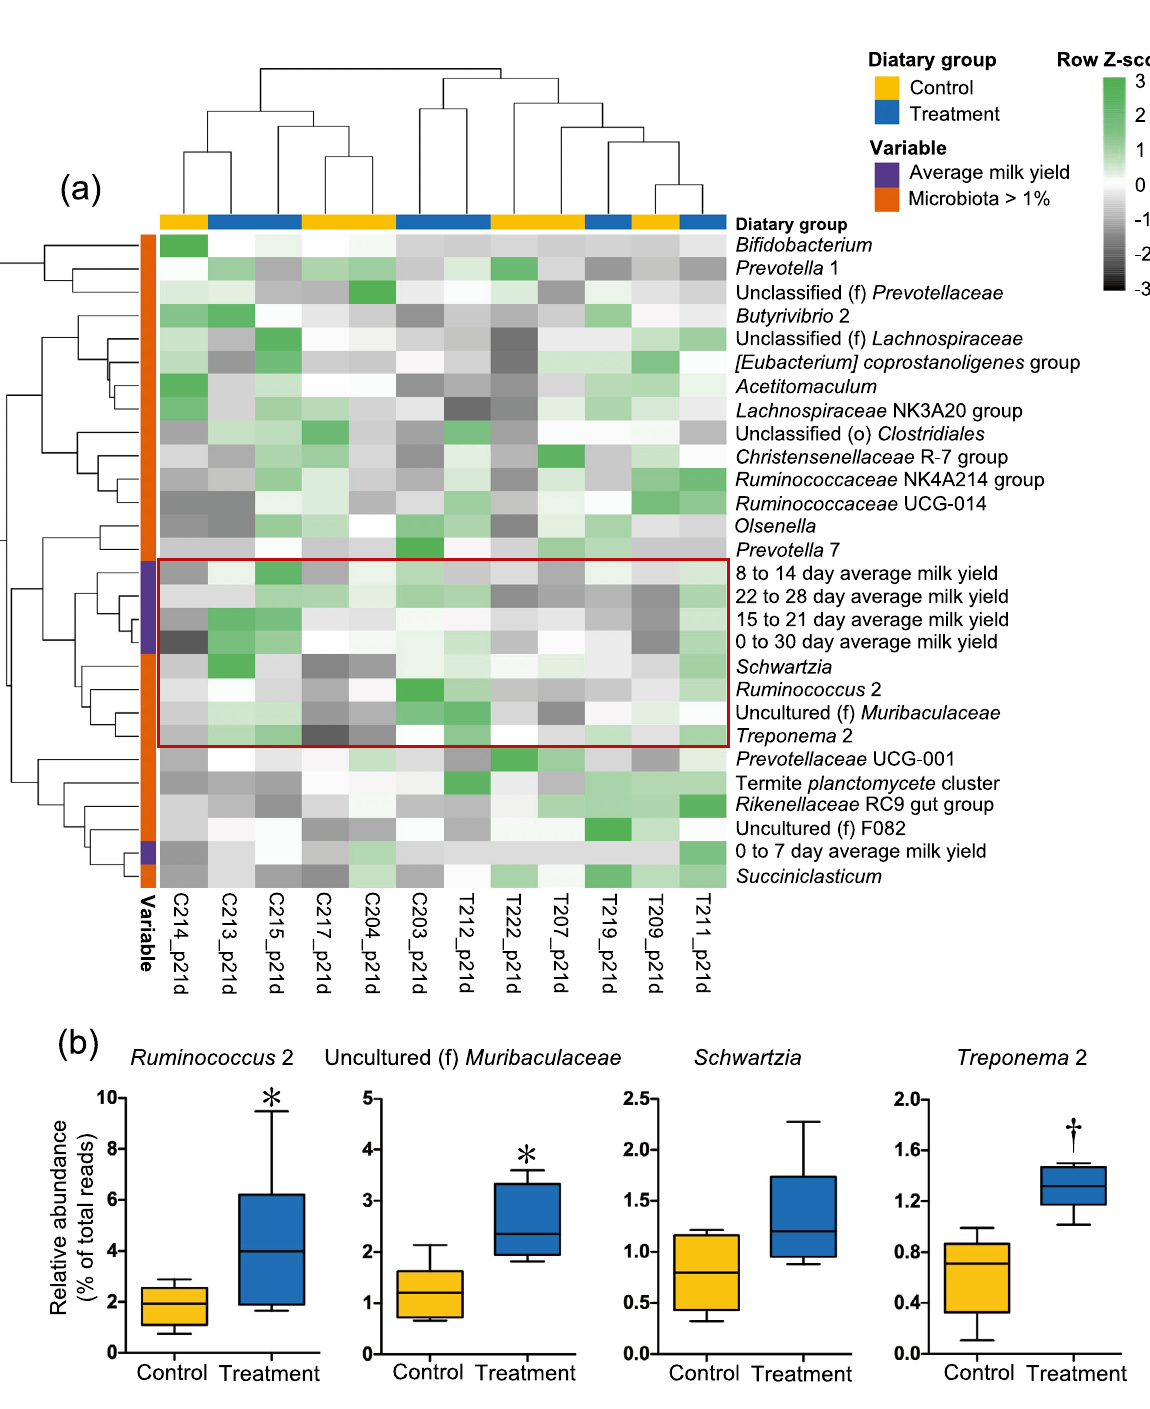
Figure 6. Exploration of the correlation between bacterial taxa and milk yield. ( a ) Heat map of hierarchical cluster analysis of rumen microbiota and milk yield. Rows represent the bacterial taxa (> 1.0% abundance) determined via 16S rRNA gene amplicon sequencing at 21 days after calving and average milk yield during the first 30 days of the lactation period. Columns represent the individual animals in each dietary group. Heat map color scale (black to green) displays the row Z-score (Z-score = [value of variable of an individual animal − mean of variable]/standard deviation). A dendrogram was generated based on Spearman’s correlation coefficient. ( b ) Relative abundance of the bacterial taxa clustered with milk yield in panel ( a ). Each box plot shows data of six animals and their range, median, and quartiles. Asterisk (*) and dagger (†) indicate significance ( P < 0.05) and tendency ( P < 0.10), respectively. P -values were calculated using a negative binomial model implemented as a Wald test in DESeq2 package in R